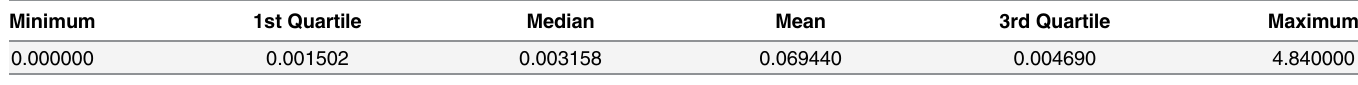
Table 1. Summary statistics of Eq 4 cost function values for all zip-codes.